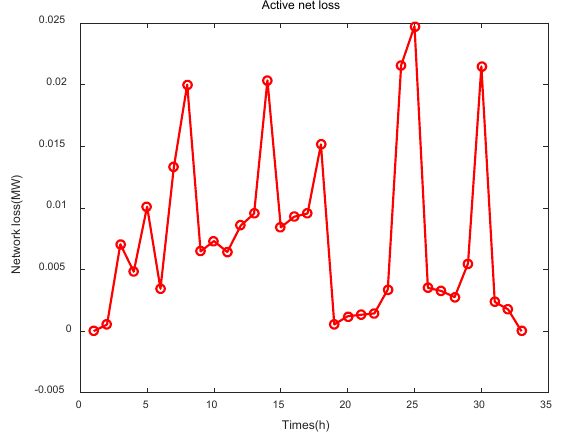
12 of 18 Figure 6. Voltage stability index for different access points. Table 2. Effect of different access points on grid voltage and stability. VBN: Voltage of the branch node. Access Nodes